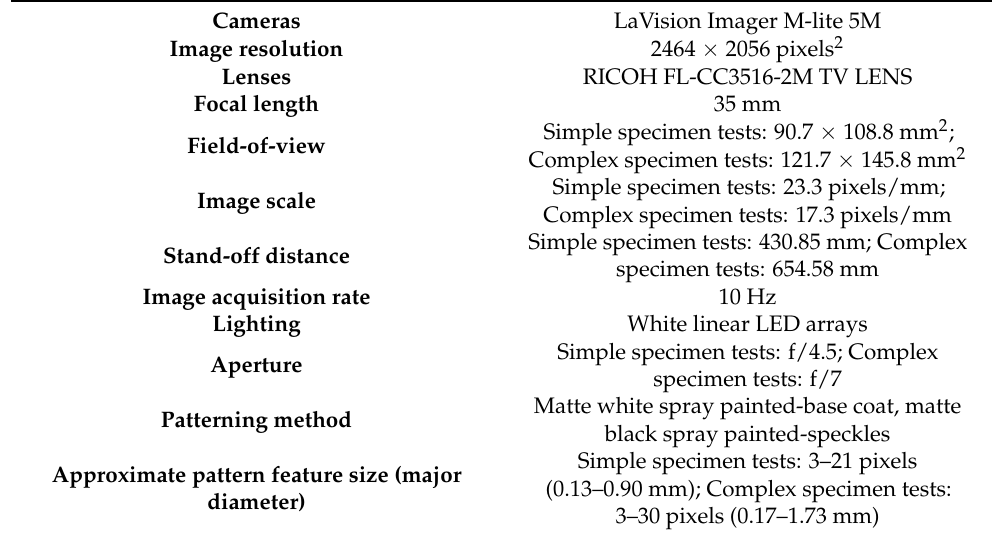
Table 1. Hardware parameters for the DIC setup. Parameters were the same for both tests, except where stated to be